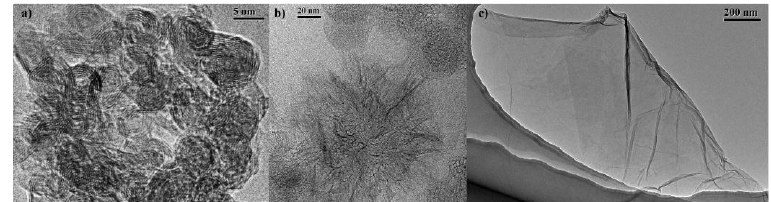
Figure 3. HRTEM images of ( a ) oxi-CNOs; ( b ) oxi-CNHs and ( c ) bright field TEM image of GO.